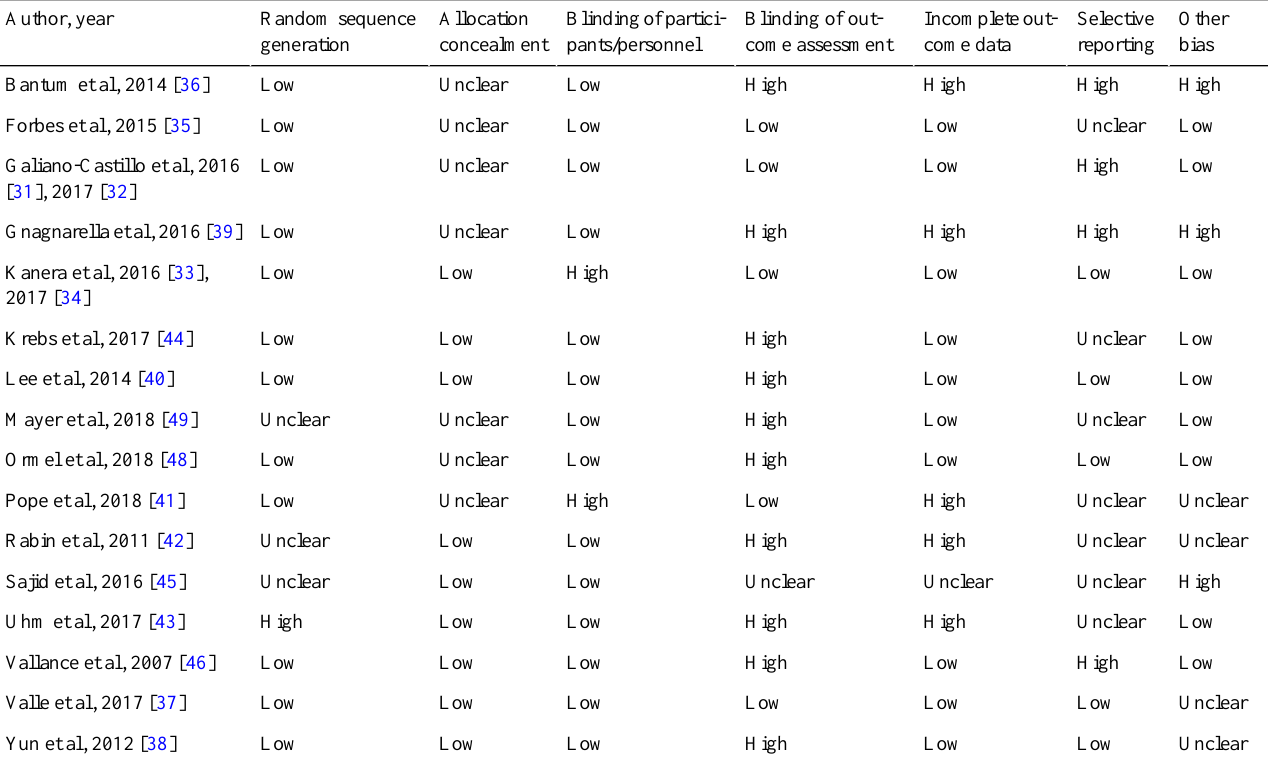
Table 3. Risk of bias for included